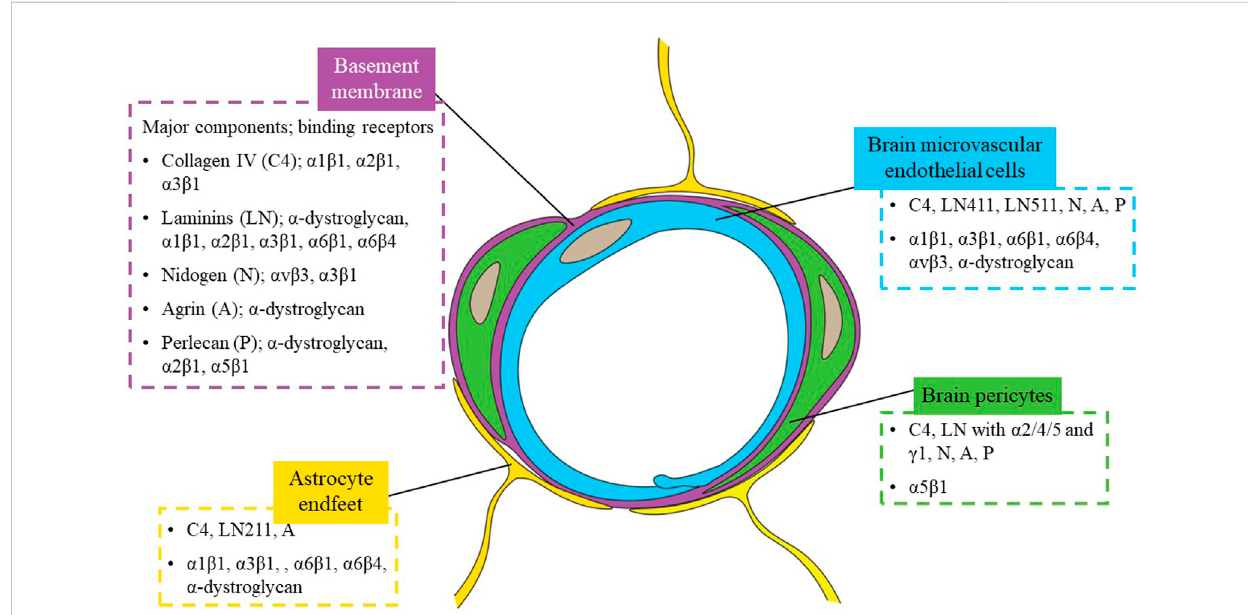
FIGURE 1 Schematic of a brain capillary cross-section. The blood-brain barrier (BBB) anatomically consists of brain microvascular endothelial cells (BMECs), surrounded by brain pericytes embedded in a shared basement membrane (BM), and astrocyte endfeet. The major extracellular matrix (ECM) proteins in the BM, collagen type IV (C4), laminin (LN), nidogen (N), agrin (A) and perlecan (P), are listed with examples of corresponding receptors in the fi gure. ECM proteins and example receptors expressed by each cell type are in respective colored